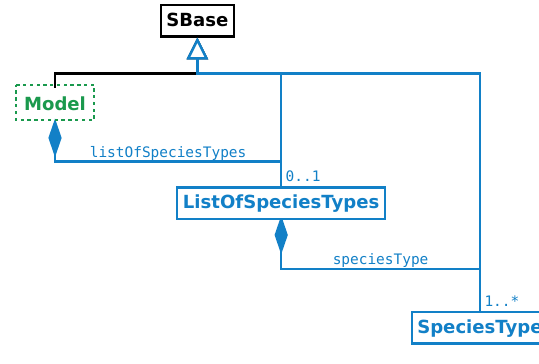
Figure 1: The extension of the Model